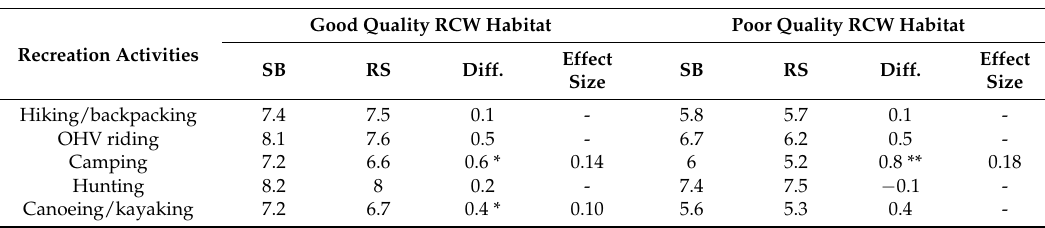
Table 3. Comparison of perceived scenic beauty and recreation satisfaction from good and poor-quality red-cockaded woodpecker habitats in Ocala National